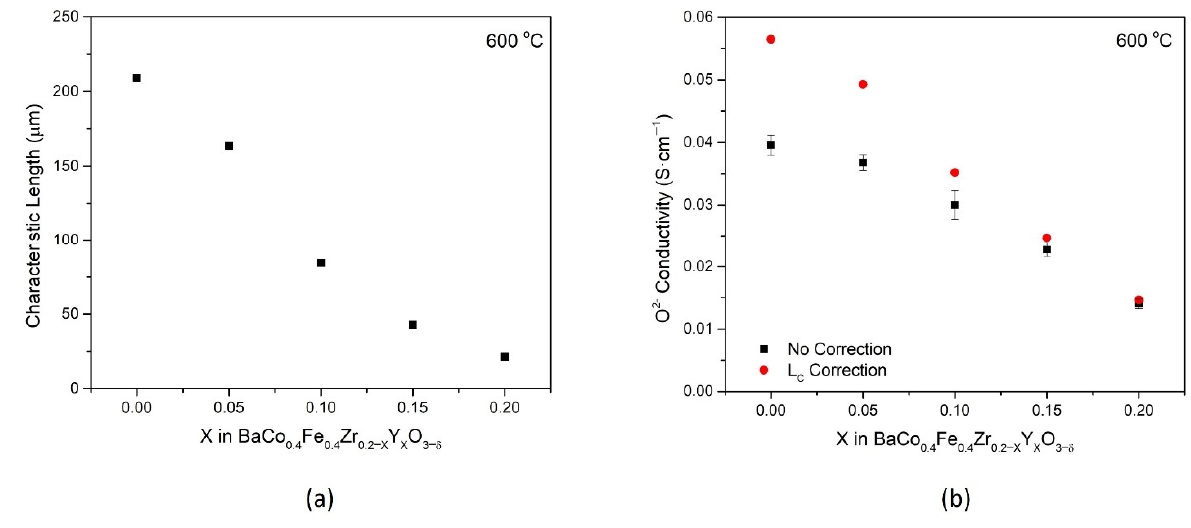
Figure 7. ( a ) The characteristic thickness, L C , at 600 °C, calculated from ECR measurements for each BCFZY X composition. ( b ) Oxygen ion conductivity estimated using the Wagner equation with and without a correction for the characteristic thickness.